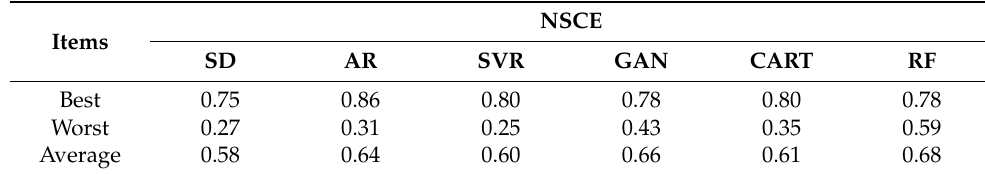
Table 9. Comparison of parameter regionalization schemes.